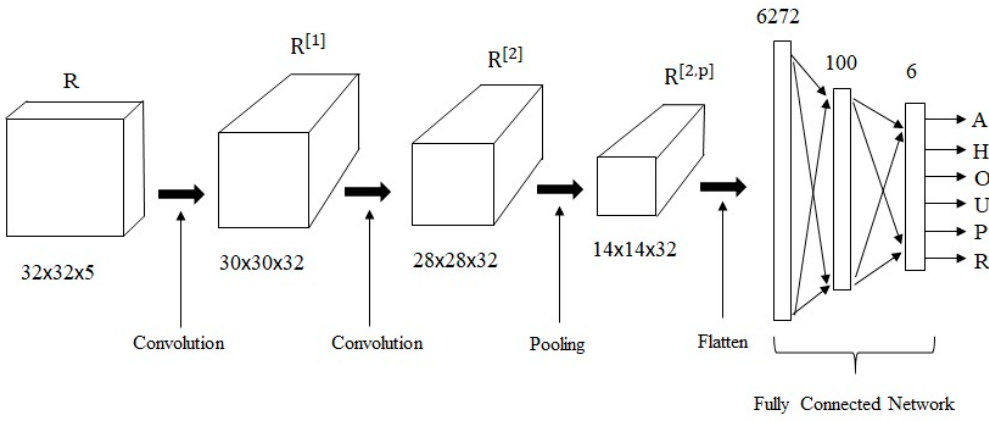
Figure 8. The architecture of the CINET(4) model used in the experiments.